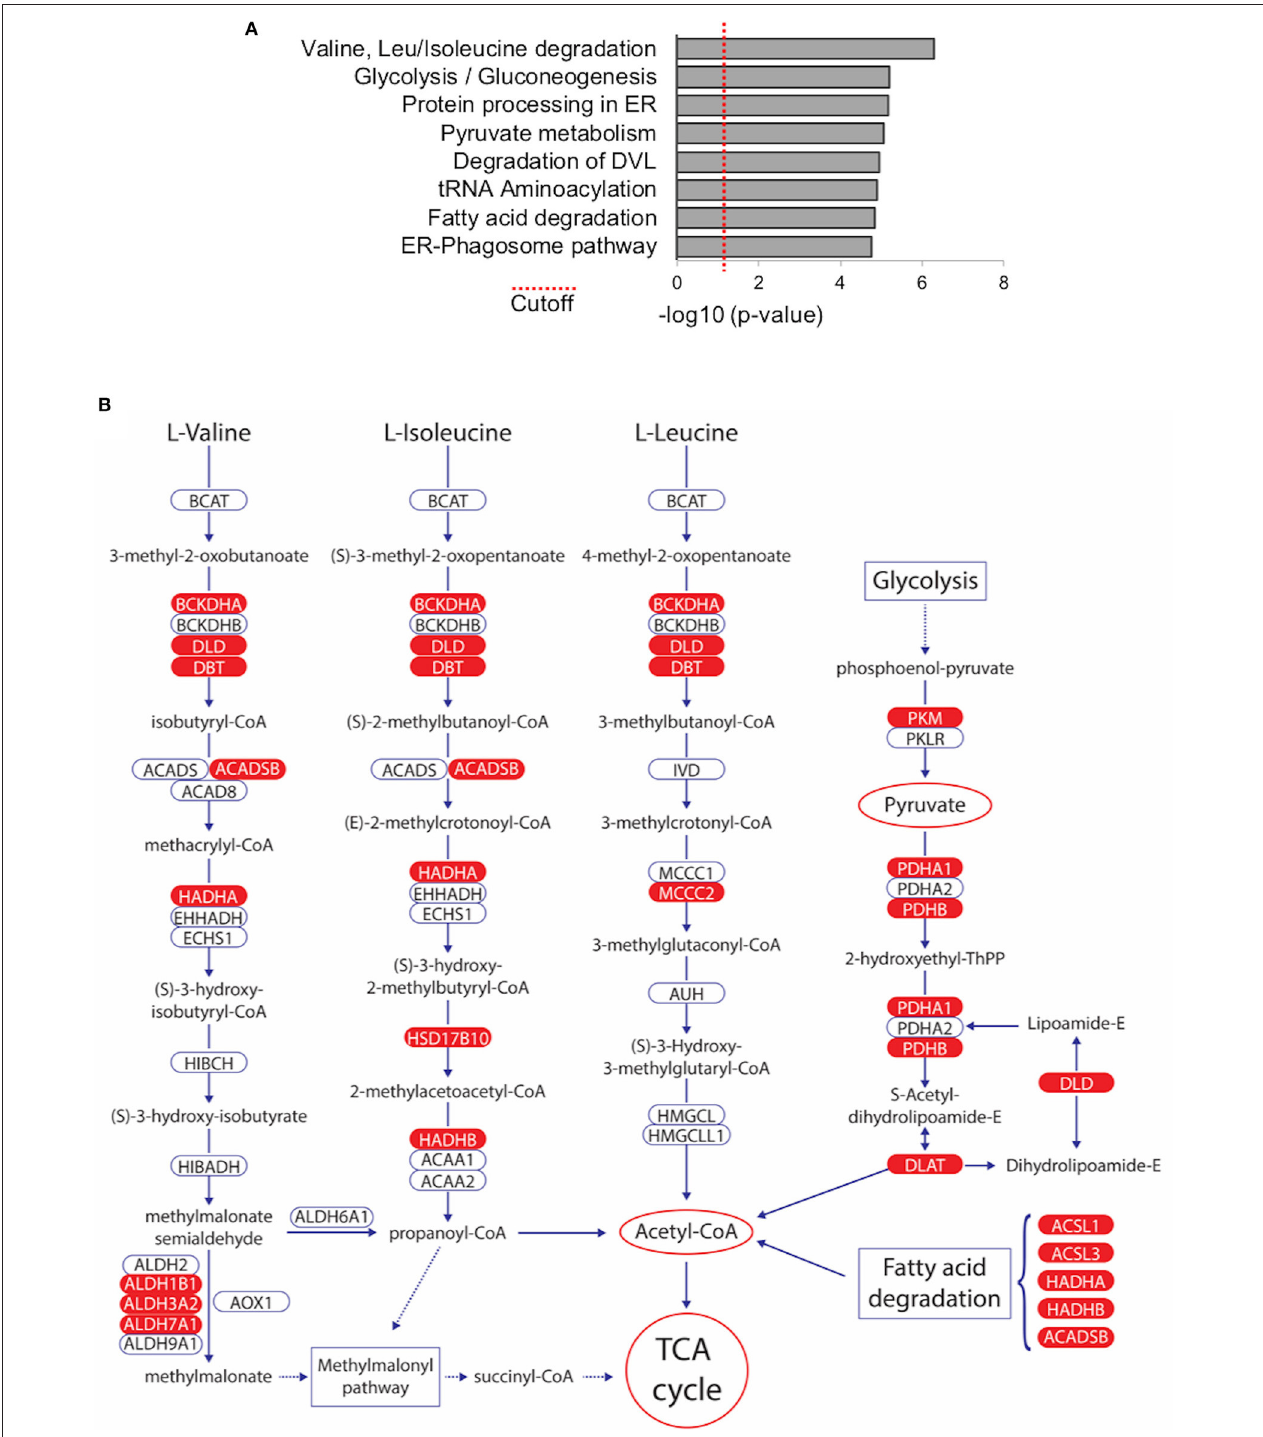
FIGURE 5 | Metabolic Pathways significantly associated with WWOX protein interactome. (A) Bar graph represents biological pathways that are significantly over-represented within the list of 216 WWOX interactors. See Supplementary File 4 for detail of interactors and p -values of pathway shown (B) Among the most significantly associated pathways we identified key metabolic pathways including: “Valine, Leucine, and Isoleucine degradation” (KEGG pathway hsa00280), “Glycolysis/Gluconeogenesis” (KEGG pathway hsa00010), “Pyruvate metabolism” (KEGG pathway hsa00620), and “Fatty acid degradation” (KEGG pathway hsa00071). All pathways converge to Acetyl-CoA generation the key molecule that delivers its acetyl group for oxidation and energy production to the tricarboxylic acid (TCA) cycle. WWOX interactors identified in our TAP-MS dataset are highlighted in red.